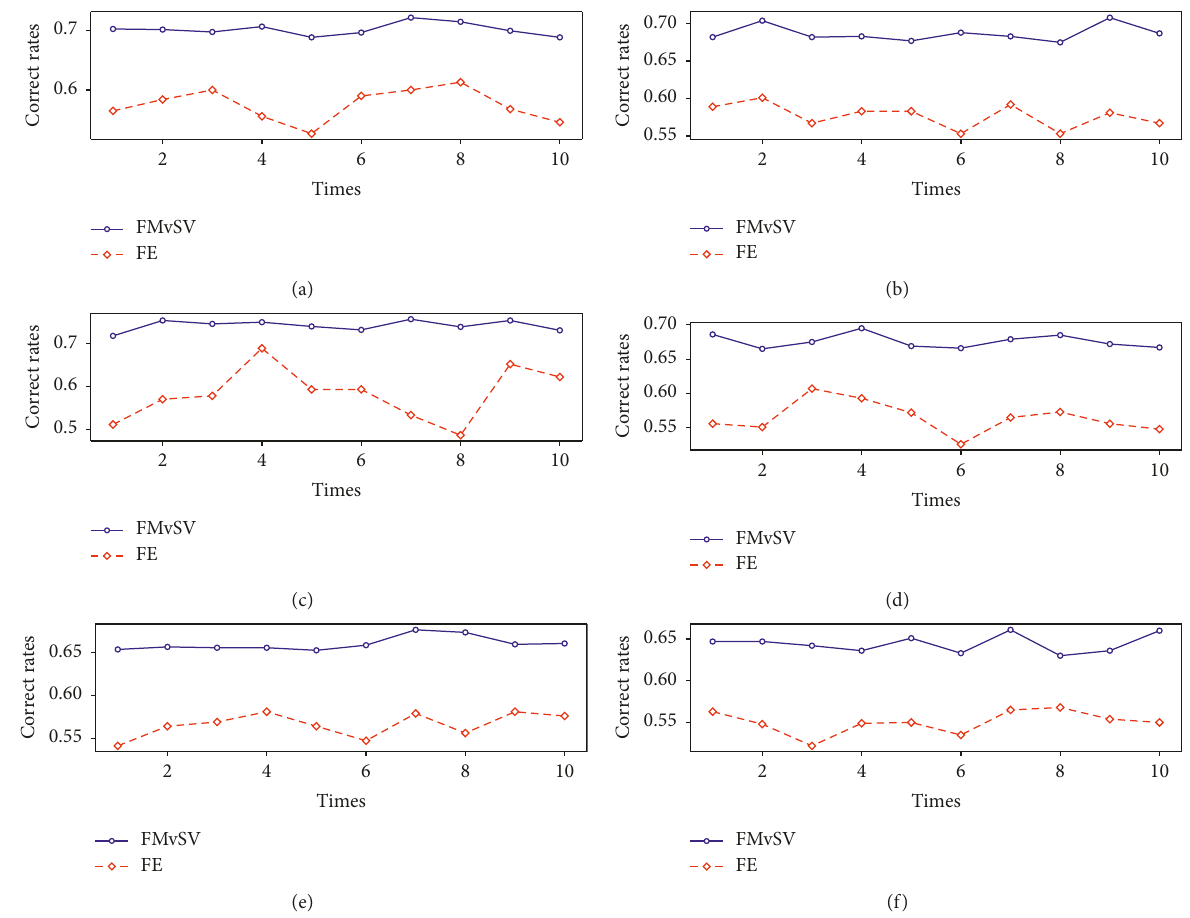
Figure 2: Comparison of the correct rates of Algorithms FMvSV and FE in terms of AD200 with 17 . 5% − 30% missing values. (a) 17.5% missing values. (b) 20% missing values. (c) 22.5% missing values. (d) 25% missing values. (e) 27.5% missing values. (f) 30% missing values. Table 10: Comparison of the correct rates of Algorithms FMvSV and FE in terms of AD200 with 2 . 5% − 30% missing values. Missing values (%) 2 .